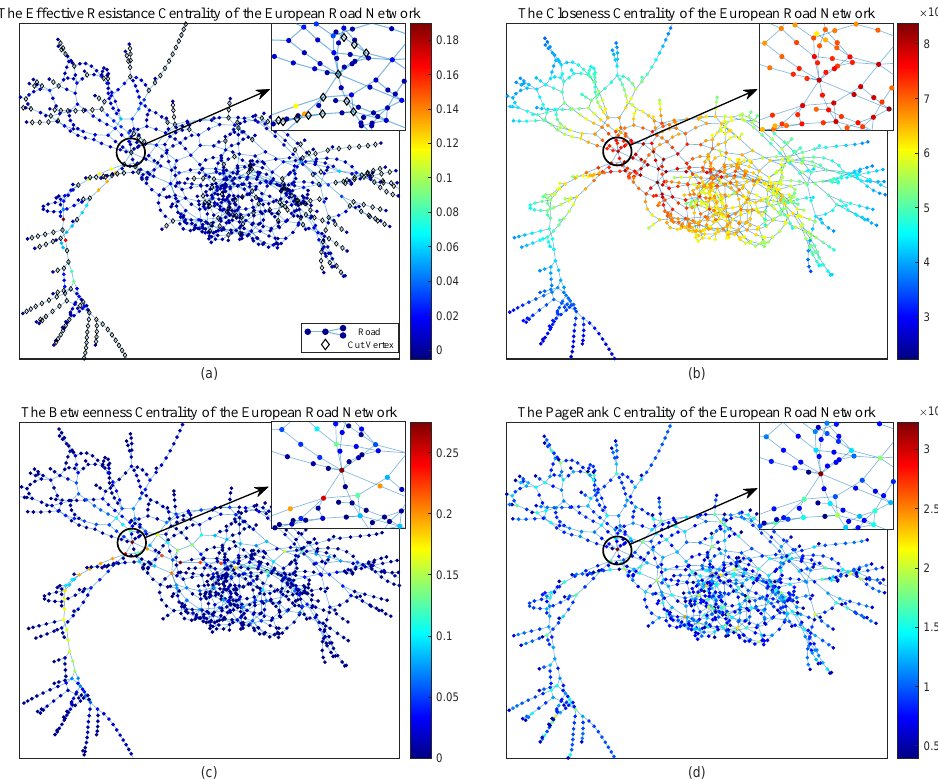
Figure 11. ( a – d ) respectively report the use of Effective Resistance Centrality, Closeness Centrality, Betweenness Centrality, and PageRank Centrality to measure the importance of each vertex of the European road